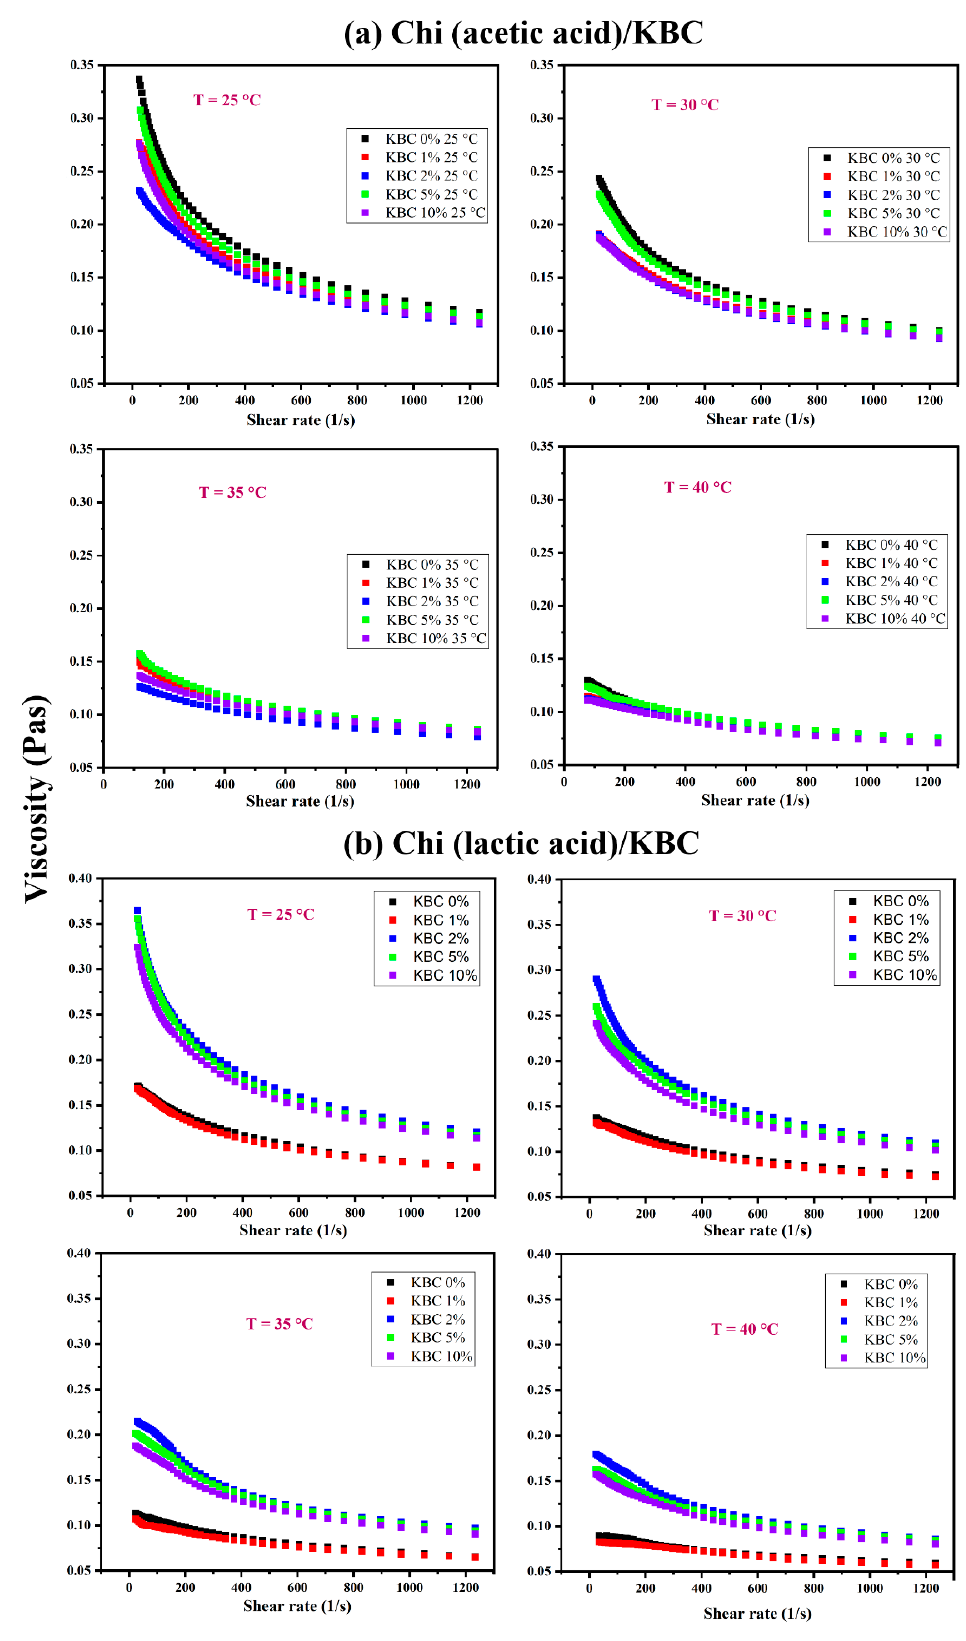
Figure 1. Variation of the viscosity of Chi dissolved in ( a ) acetic acid and ( b ) lactic acid containing various KBC concentrations at 25, 30, 35, and 40 °C.